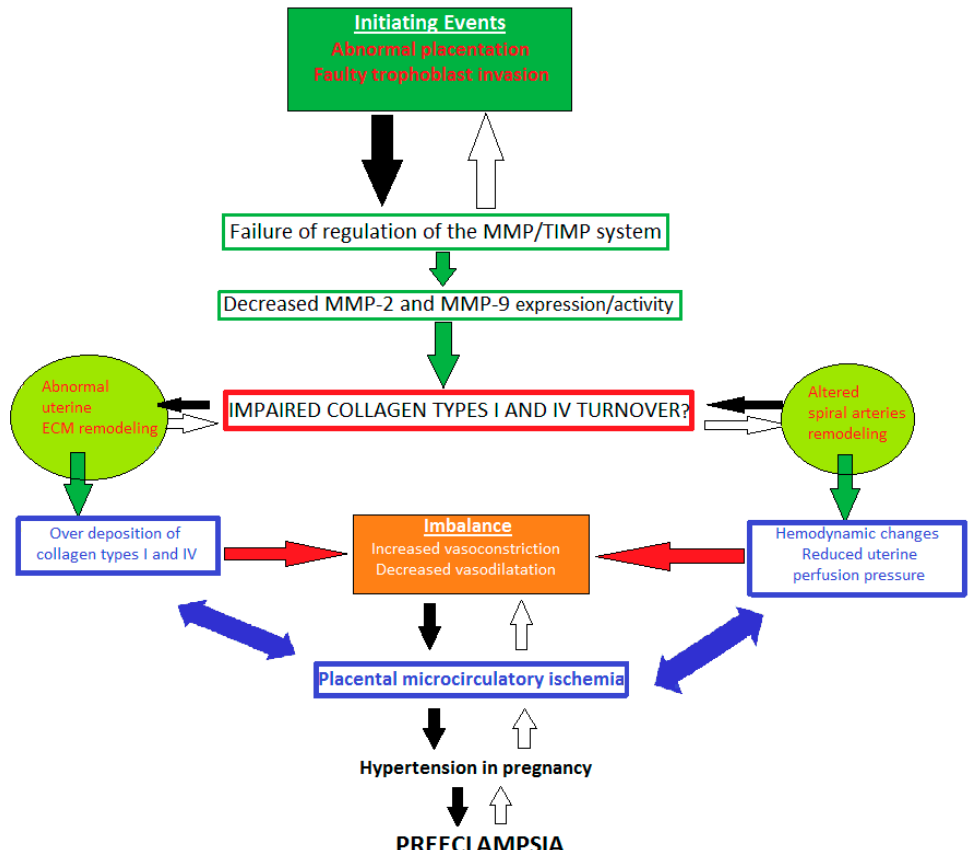
Figure 1. A possible schematic pattern illustrating the eventual mechanisms of impaired collagen I and IV turnover in pathological pregnancy.